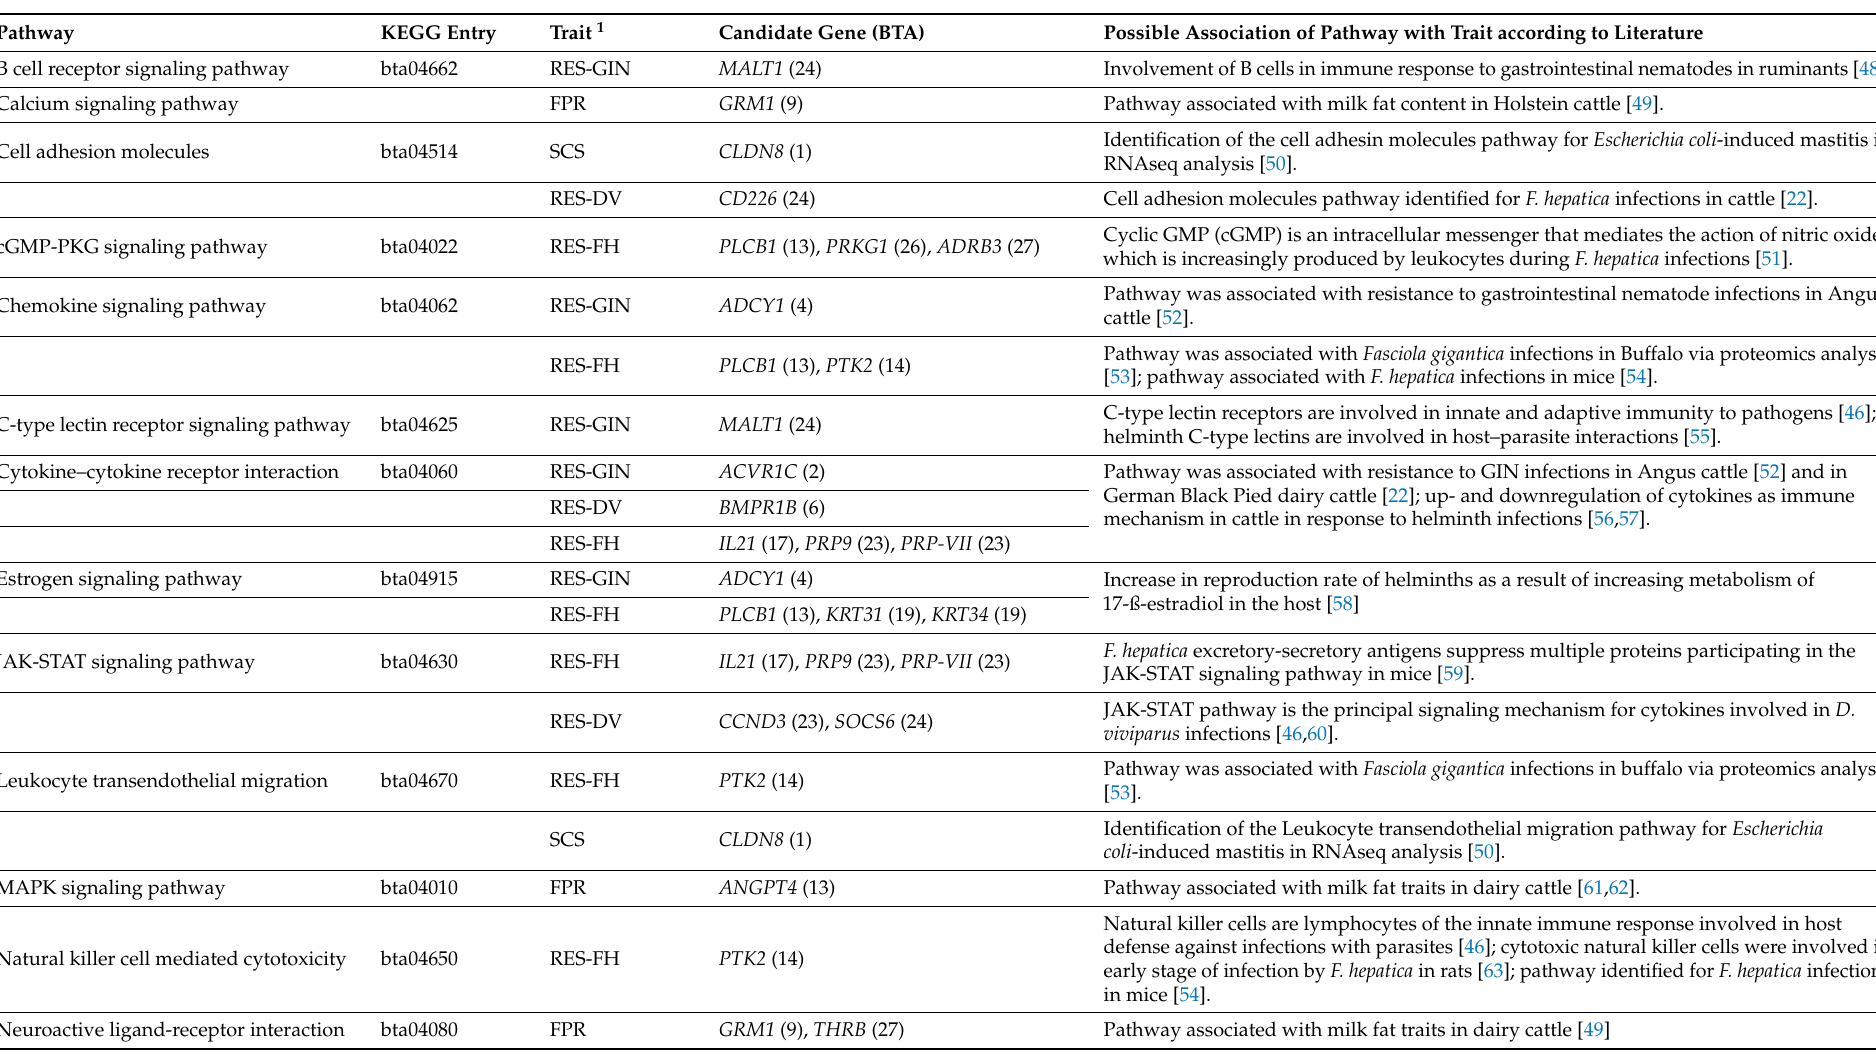
Table 4. Pathways (sorted alphabetically) related to the identified candidate genes associated with fat-to-protein ratio (FPR), somatic cell score (SCS), and endoparasite infection traits (RES-GIN, RES-FH, RES-DV), selected from the DAVID and KEGG databases and previously described in literature to be associated with the corresponding trait. Pathway KEGG Entry Trait